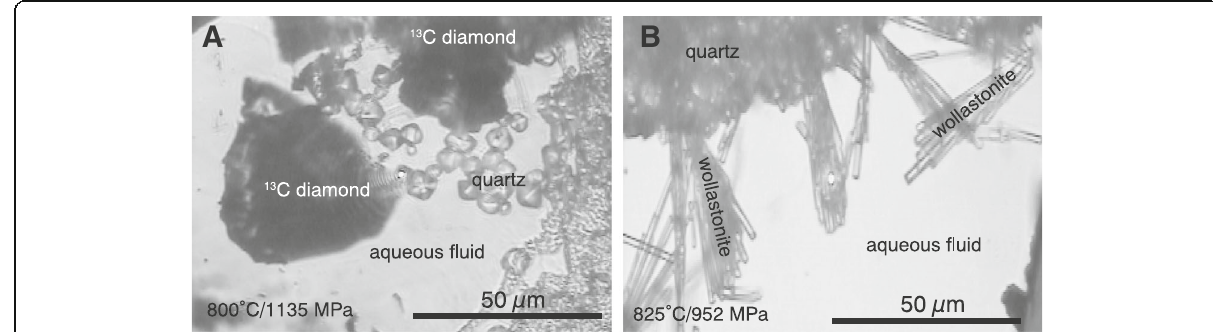
Fig. 1 Examples of microphotographs of samples in the hydrothermal diamond anvil cell at high temperature and pressure. a View of the sample from SiO 2 – NaOH – H 2 O at 800 °C and 1135 MPa. b View of the sample from SiO 2 – CaO – H 2 O at 825 °C and 925 MPa